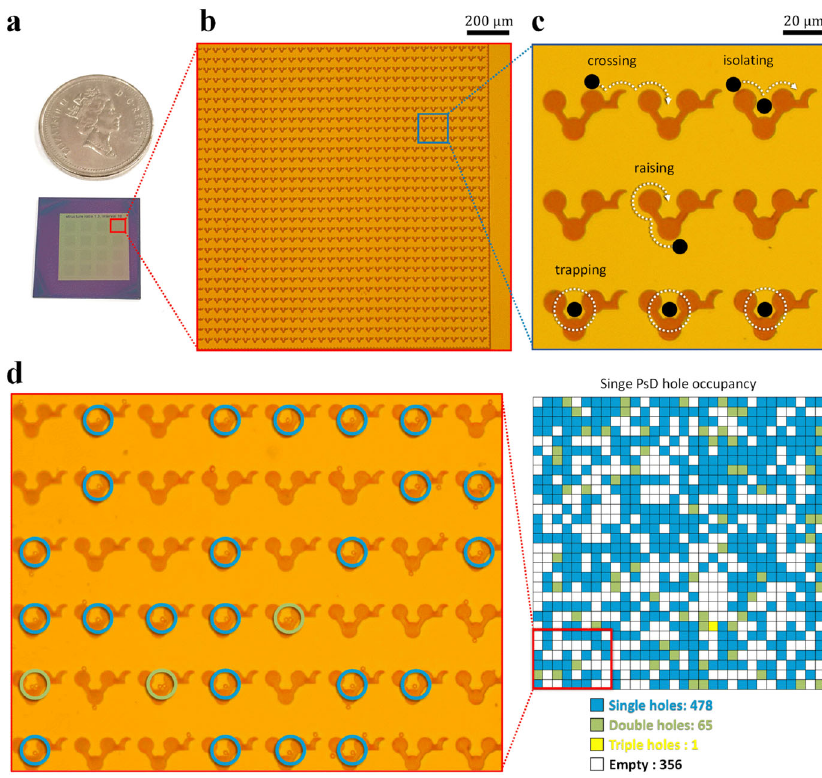
Fig. 10 Throughput ef fi ciency of PsD holes. a The microfabricated chip contains 14,400 storage compartments in a 4 × 4 array. b Optical image of the micro-magnetic arrays consists of 900 storage compartments. c Magni fi ed optical image of the U-shaped storage compartments. d Optical image showing the storage of PsD holes in multiple